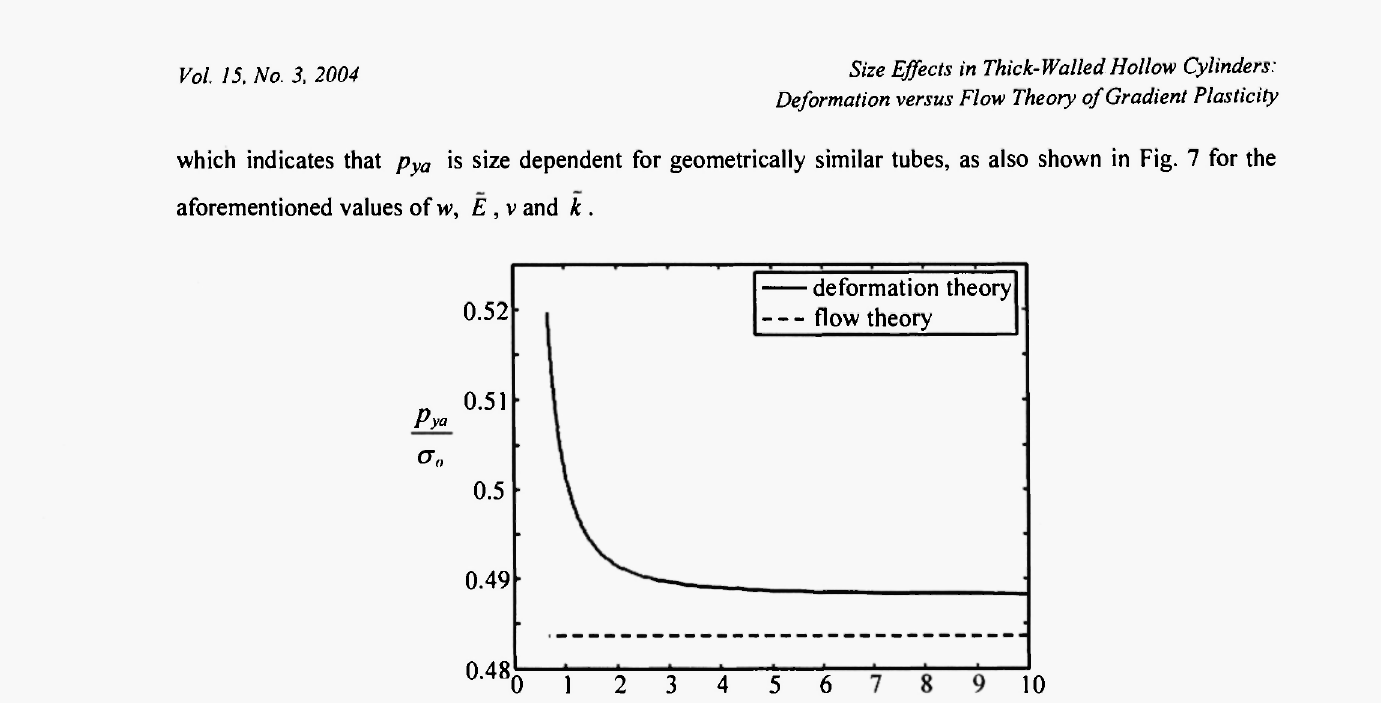
Fig. 7: Comparison of the size effect on the pressure p ya at the onset of plastic deformation predicted by the deformation theory and the flow theory of gradient